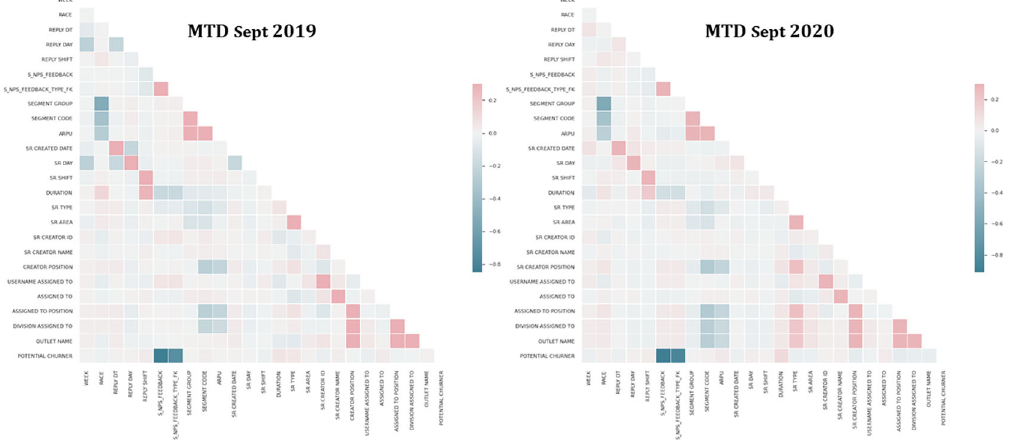
Figure 3. Correlation coefficient results for MTD Sept 2019 and MTD Sept